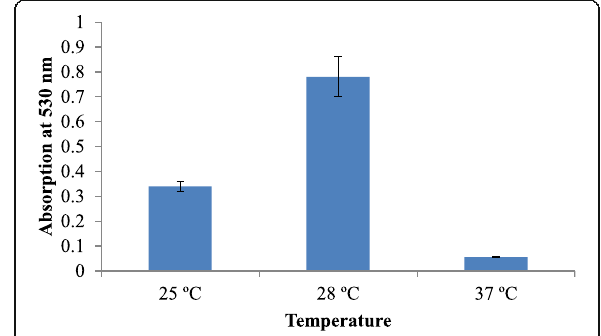
Fig. 2 Effect of temperature on prodigiosin production